Question: Looking at the figure, what chart type is it?
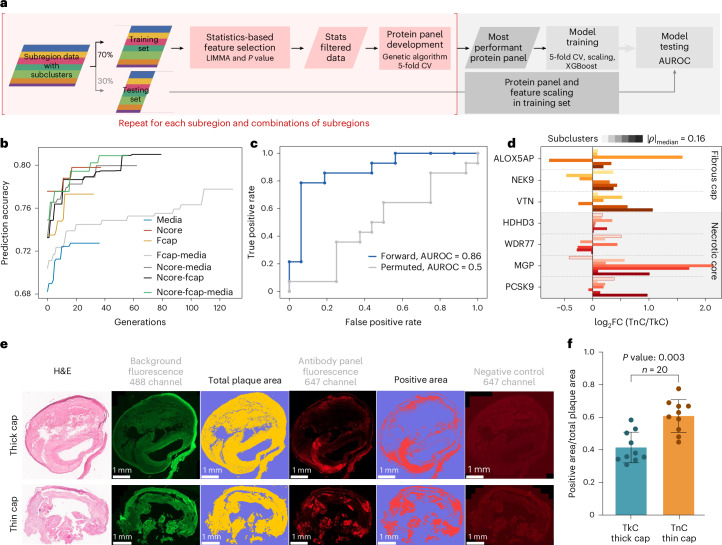
Answer: bar